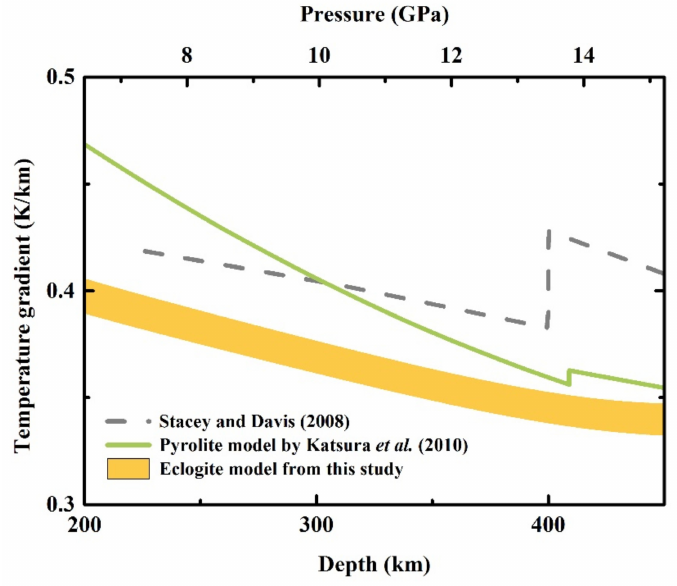
Figure 8. Adiabatic temperature gradients in the depth range of 200–450 km. The lower and upper edges of the filled area are calculated with T P as 1623 K and 1683 K, respectively.